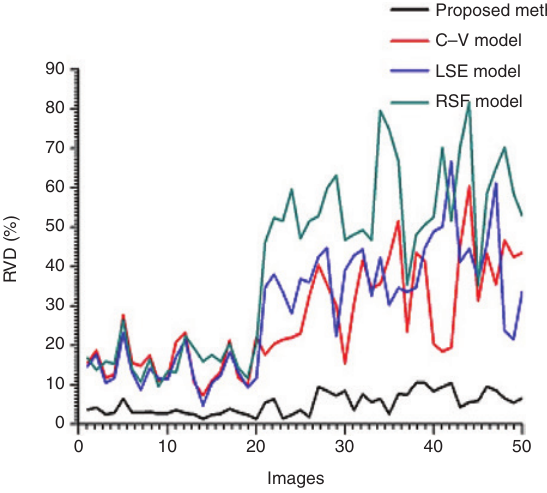
Figure 10: Comparison of Results Using RVD for MRI Scan Images.